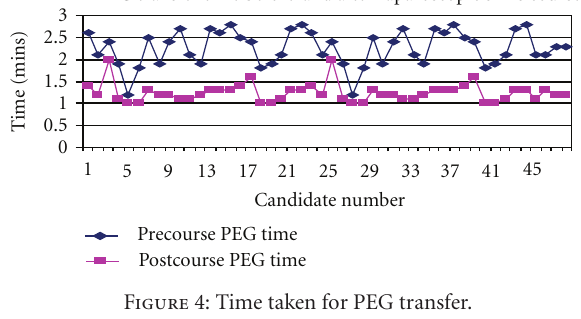
Figure 4: Time taken for PEG transfer.